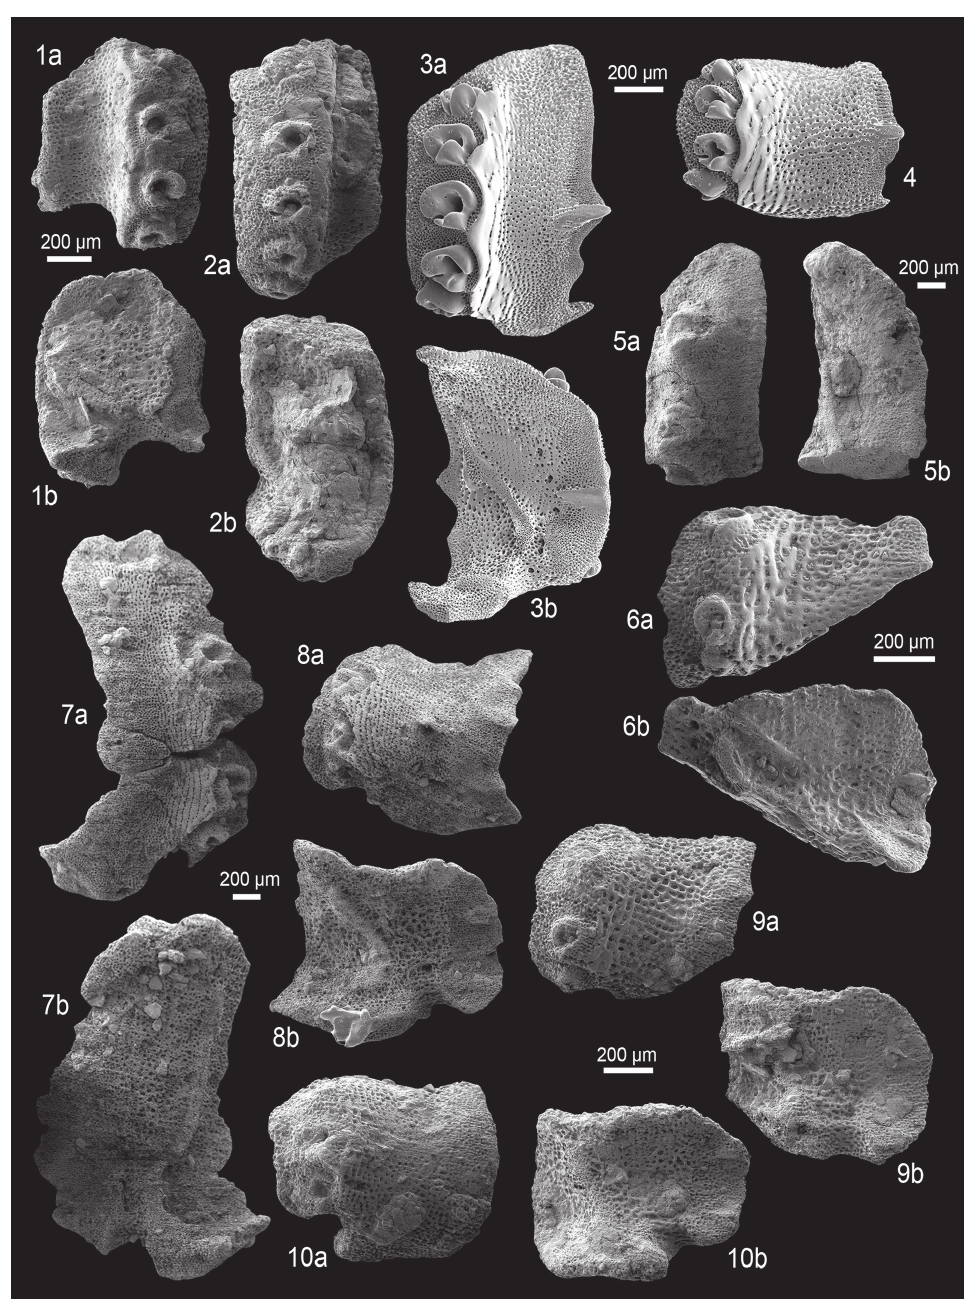
Fig. 22. Lateral arm plates (LAPs) of fossil and Recent ophiacanthid brittle stars in external (a) and internal (b) views. 1-2. Hanshessia sp. from the Callovian (Middle Jurassic) of Jumara, India. 1. GZG. INV.78641, proximal to median LAP. 2. GZG.INV.78642, proximal LAP. 3-4. Ophiocopa spatula